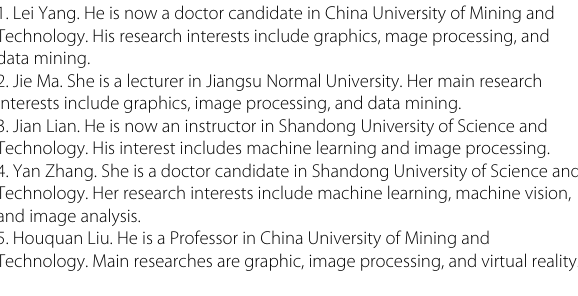
the proposed approach, we conducted comparison exper- iments between the state-of-the-art methods and ours on several publicly available face image datasets. Experimen- tal results show that the proposed approach outperforms the state-of-the-art methods in